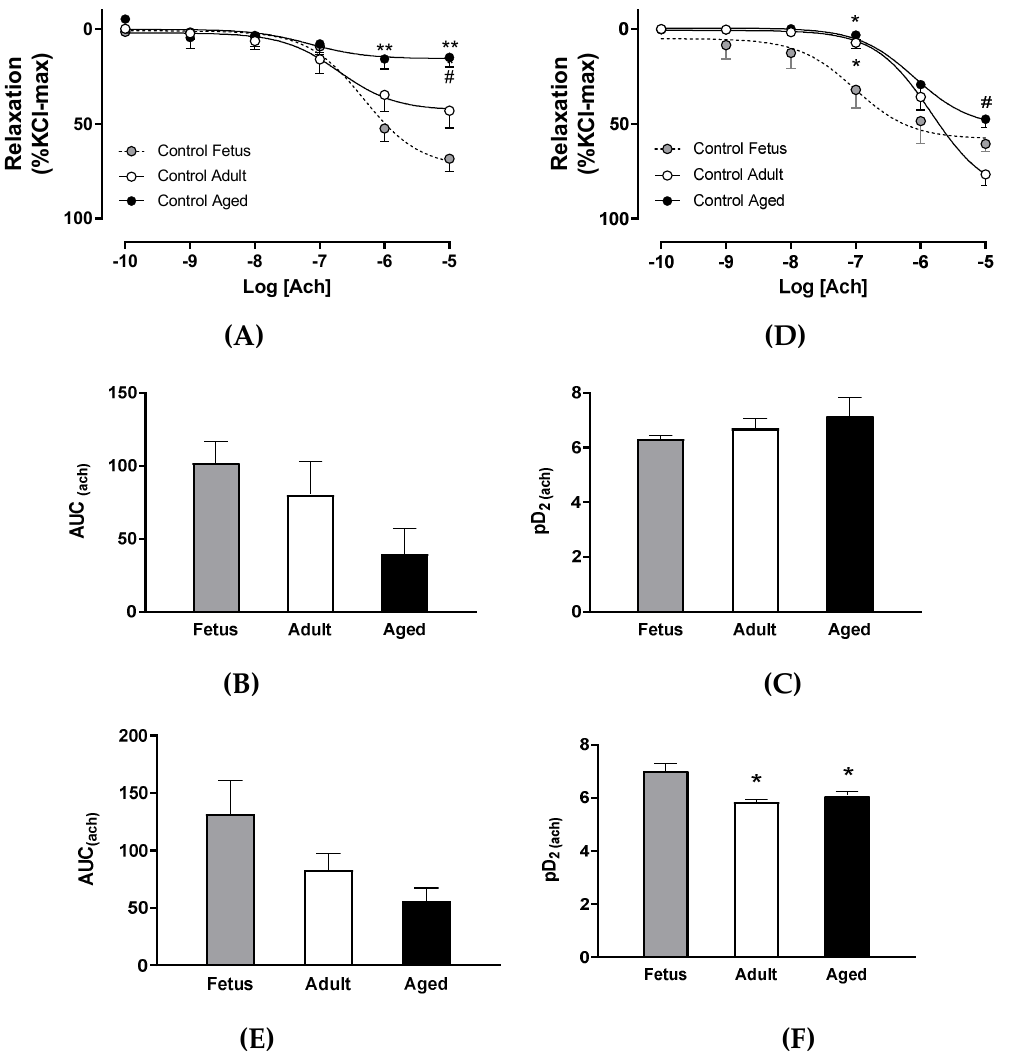
Figure 2. Ex vivo endothelial function in arteries from fetal to aged guinea pigs. Concentration-dependent relaxation in response to acetylcholine in carotid ( A ) and femoral arteries ( D ) from control fetus (gray circles, dashed black lines), control adult (open circles, continuous black lines), and control aged guinea pigs (solid circles, continuous black lines). Area under curve and pharmacological potency (pD 2 , i.e., sensitivity) of acetylcholine in carotid ( B , C, respectively) and femoral arteries ( E , F, respectively) from control fetus (gray bar), control adult (open bar), and control aged guinea pigs (black bar). Values are expressed in mean ± SEM. * p < 0.05, ** p < 0.01 vs term fetus. # p < 0.05 vs adult.